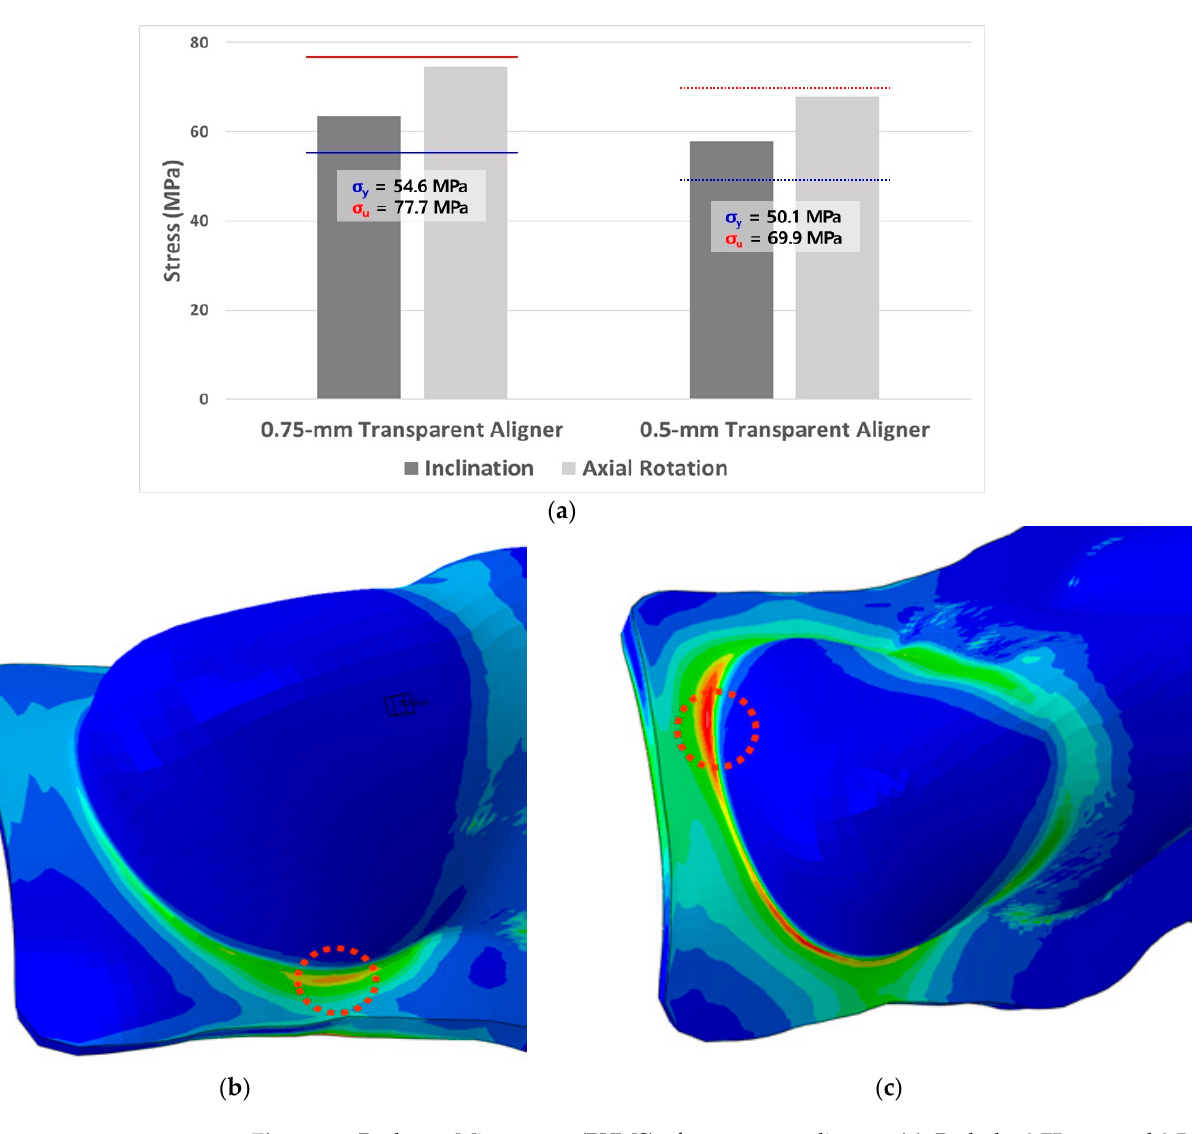
Figure 18. Peak von Mises stress (PVMS) of transparent aligners. ( a ), Both the 0.75-mm and 0.5-mm transparent aligners showed that PVMS was higher than the yield stress of the material after ortho- dontic treatment. Thus, restoring the original shape would be difficult; ( b ), In inclination treatment, both transparent aligners had the highest PVMS in the buccal direction in the area where the crown and gingiva of the central incisor were in contact; ( c ), In axial rotation correction, the highest PVMS was expected at the lingual-mesial point, suggesting that deformation and breakage of the area may be high after orthodontic treatment.